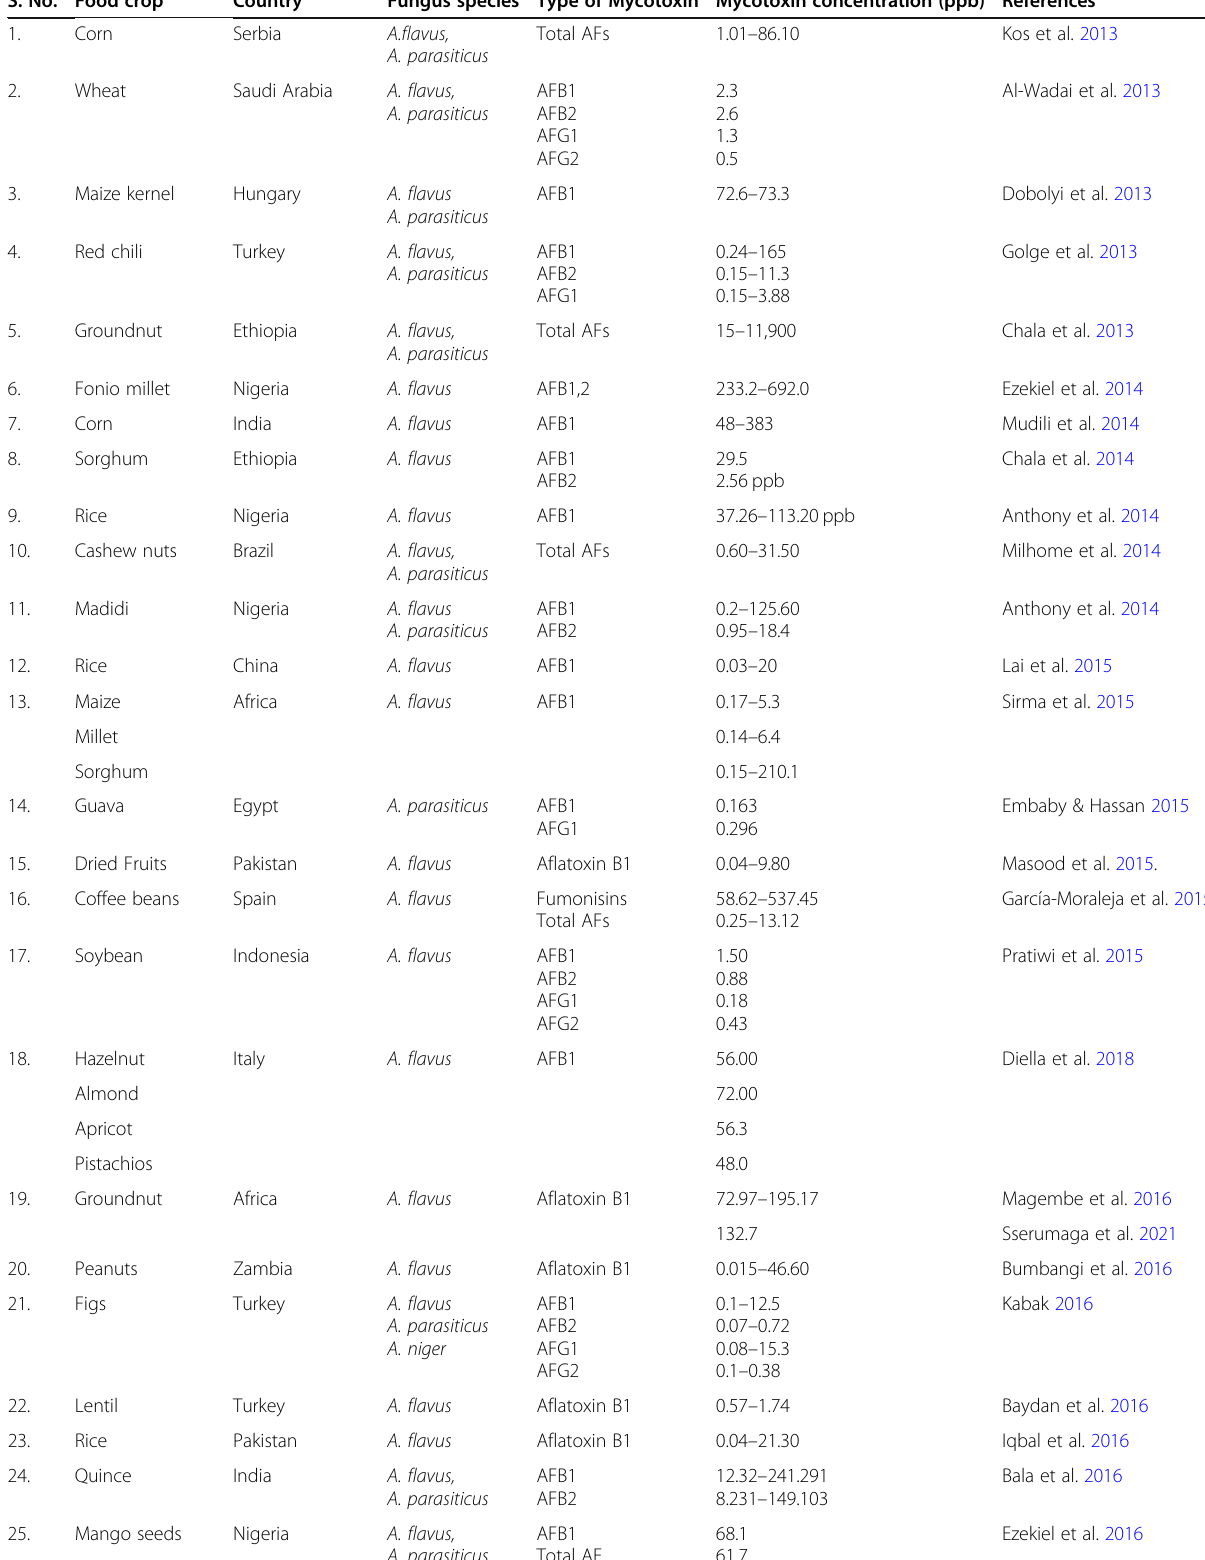
Table 1 List of recent studies showing the mycotoxin contamination in different food